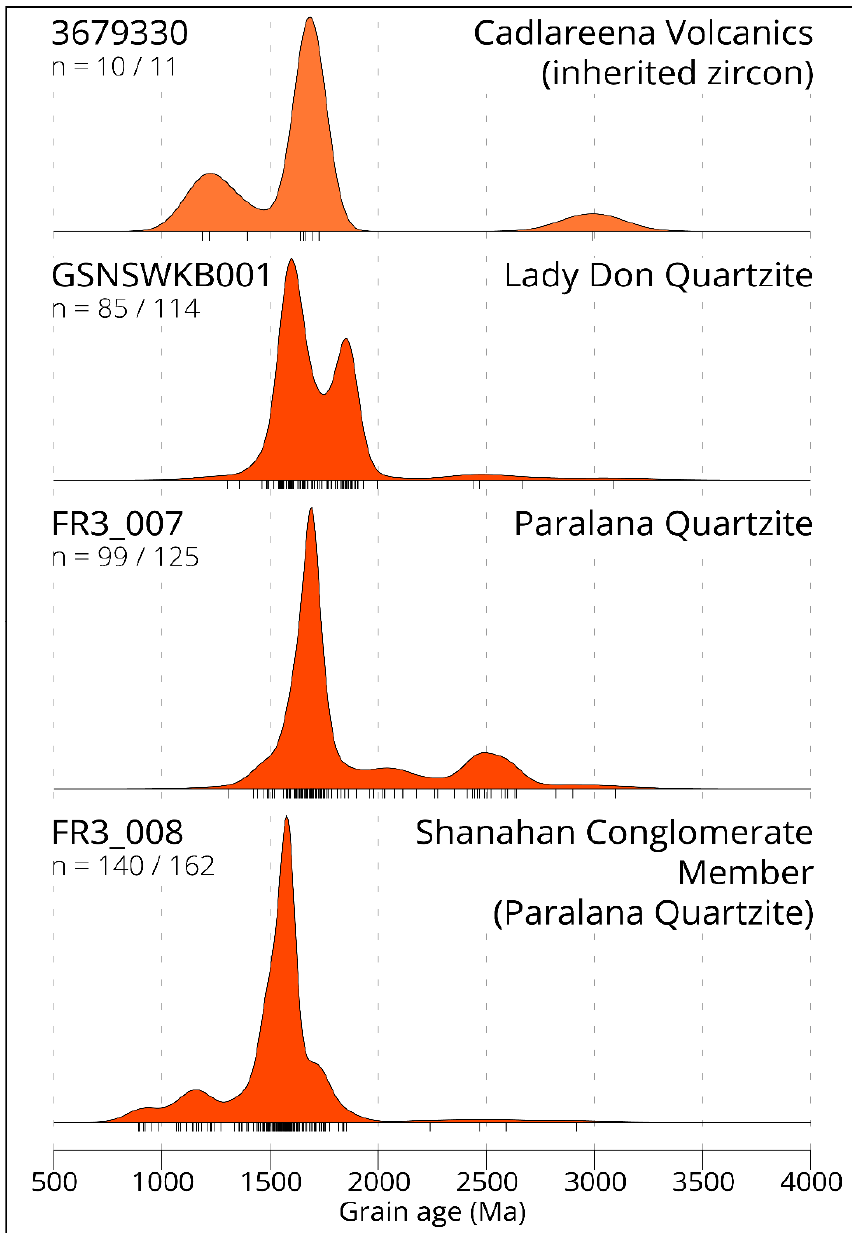
Figure 4. Kernel density estimate plots of the four samples analysed in this study. The plots are shown in ascending stratigraphic order. Tick marks below each plot represent an analysis. n = filtered analyses/total analyses. Created using IsoplotR [69].